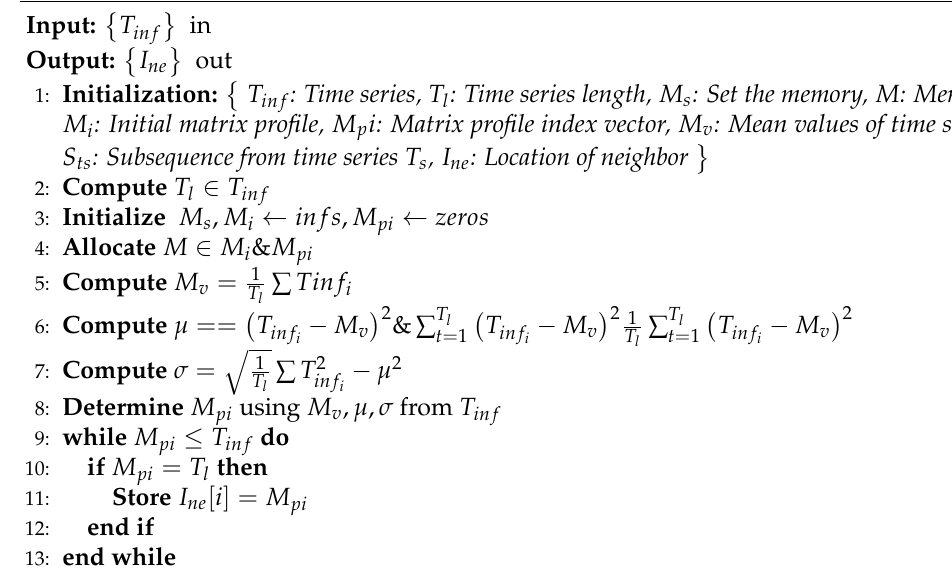
Algorithm 2 Immediate Neighbor Detection